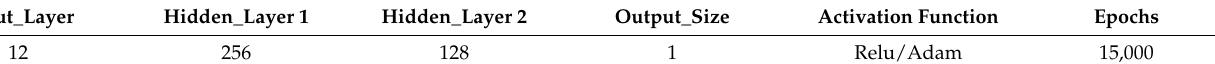
Table 2. Hyper parameters of the MNN for SOC estimation.